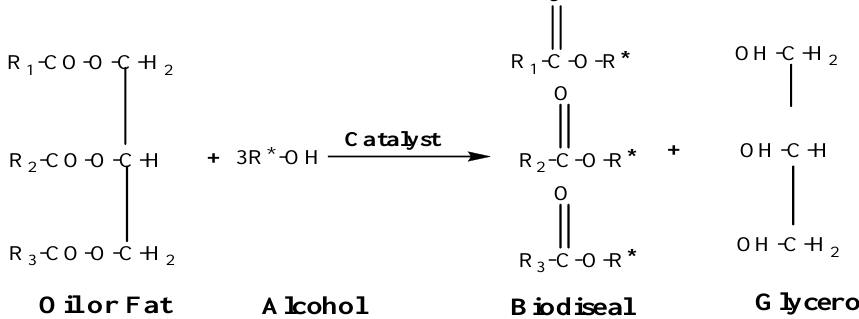
Figure 1: General chemical equation for biodiesel formation